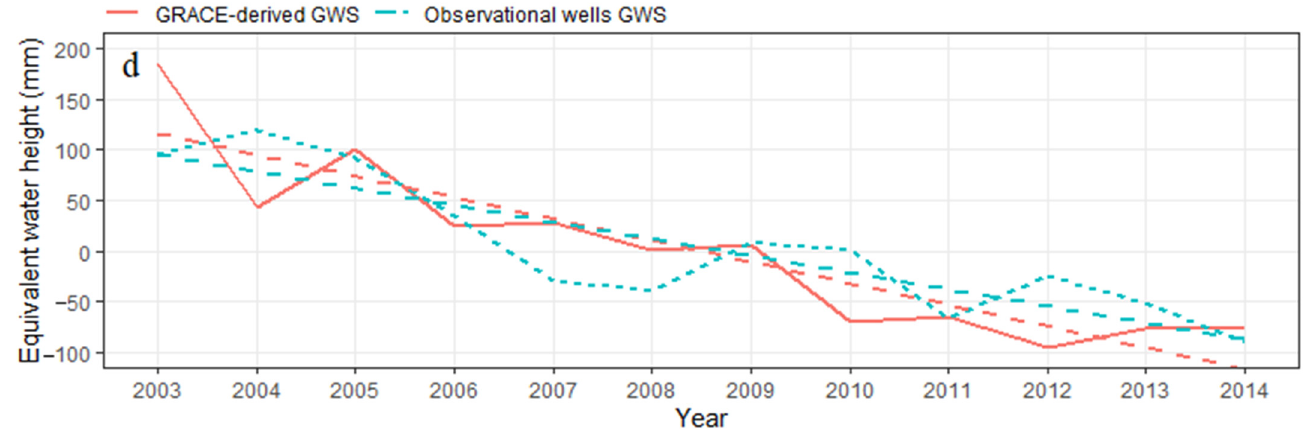
Figure 13. Comparison of observational wells, downscaled, and GRACE-derived GWS time series ( a , b ) at the seasonal scale and ( c , d ) at the annual scale.